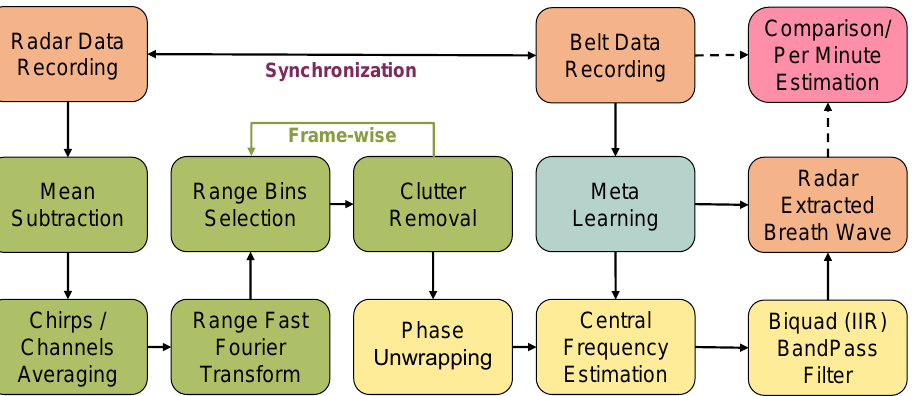
Figure 5. Preprocessing pipeline. First, the phase information is unwrapped from the raw radar data. The respiration signal and Fc are then estimated by Meta-L, exploiting only in the training phase the data collected with the respiration